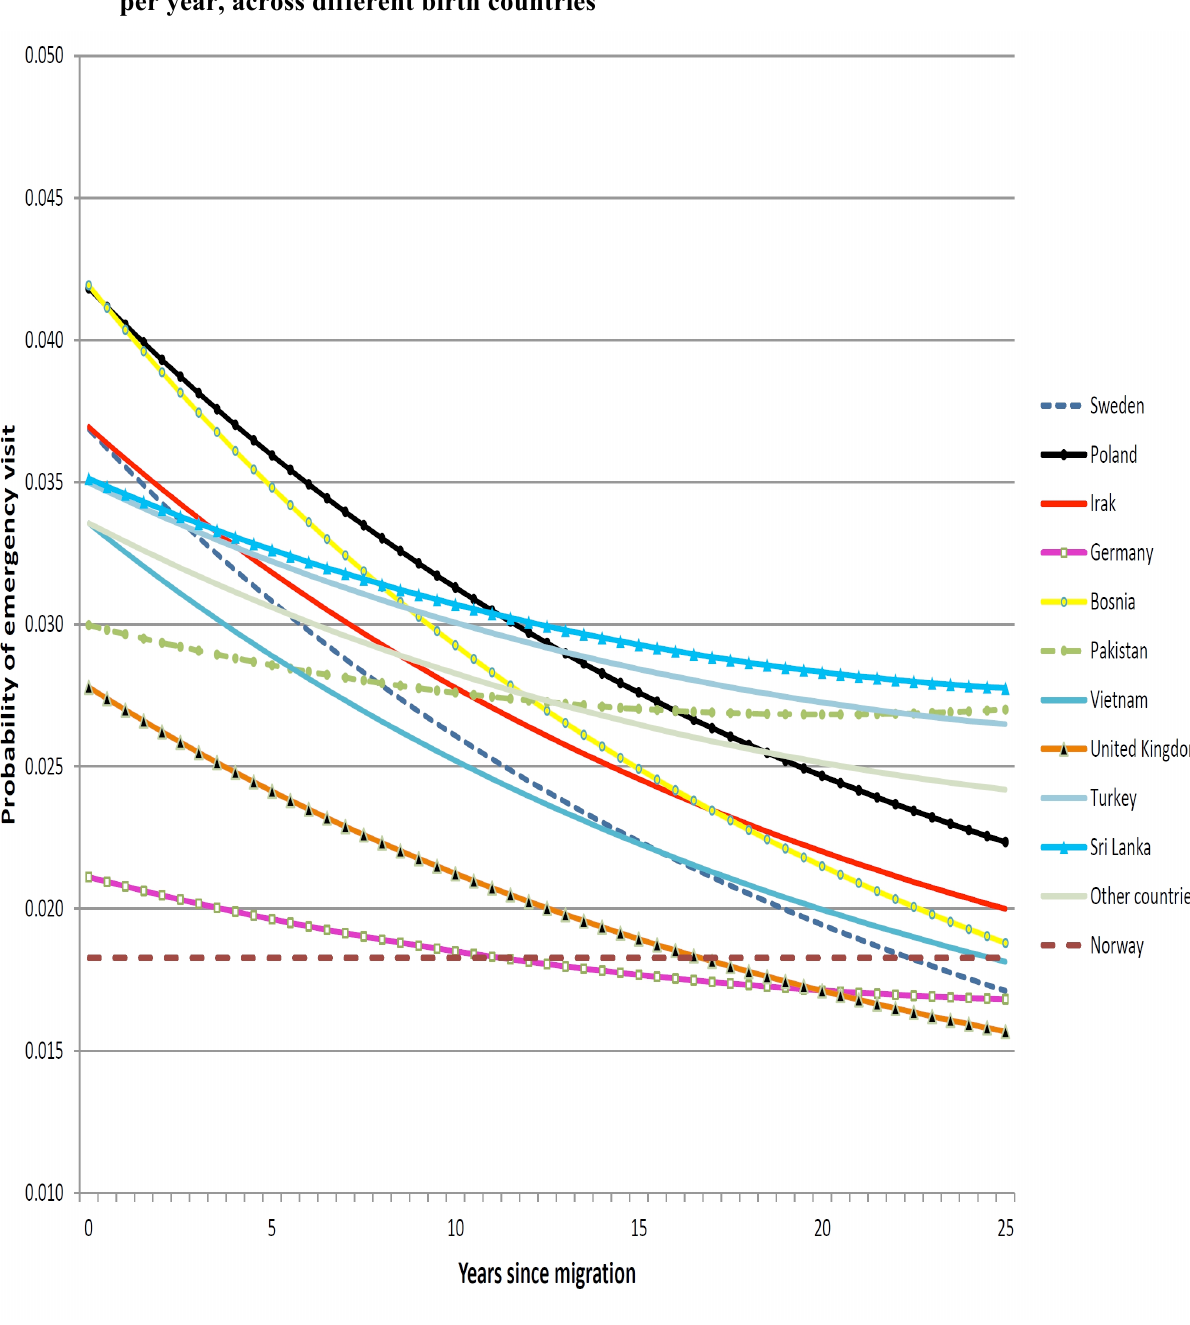
The estimated impact of years of residence on the probability of an emergency visit for a female aged 45 with two primary care consultation per year, across different birth